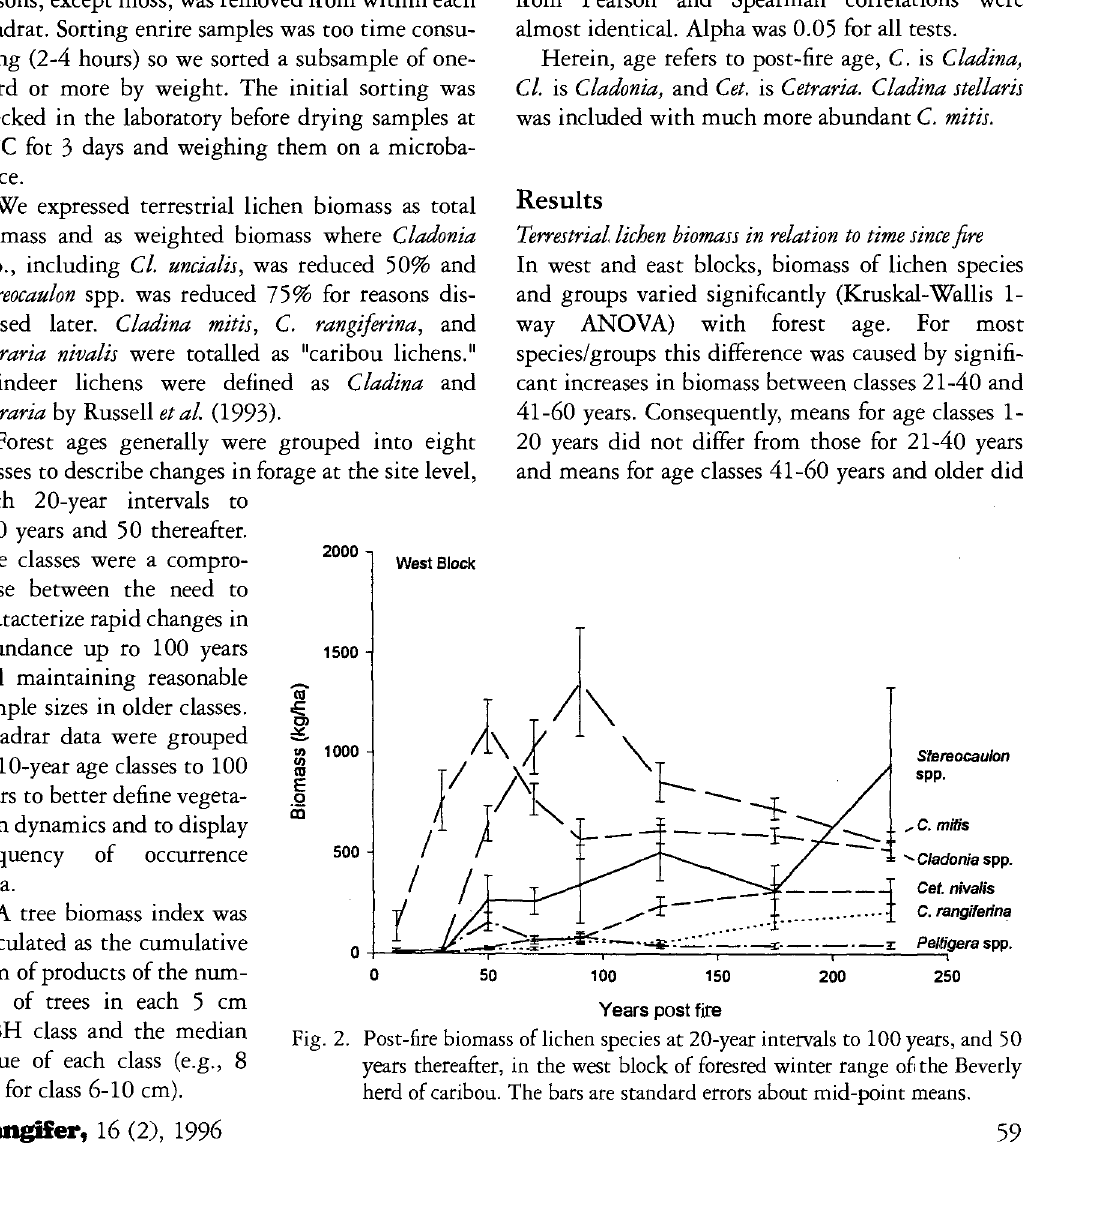
Post-fire biomass of lichen species at 20-year intervals to 100 years, and 50 years thereafter, in the west block of foresred winter range of the Beverly herd of caribou. The bars are standard errors about mid-point